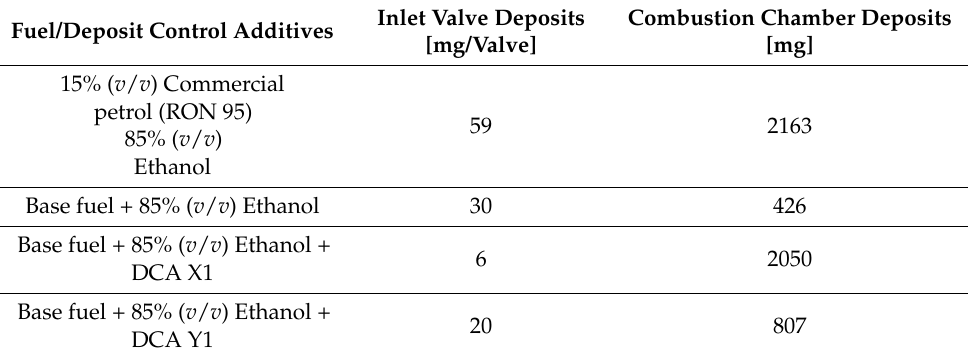
Table 7. Effectiveness tests results of deposit control additives (DCA) batches from renowned manufacturers X and